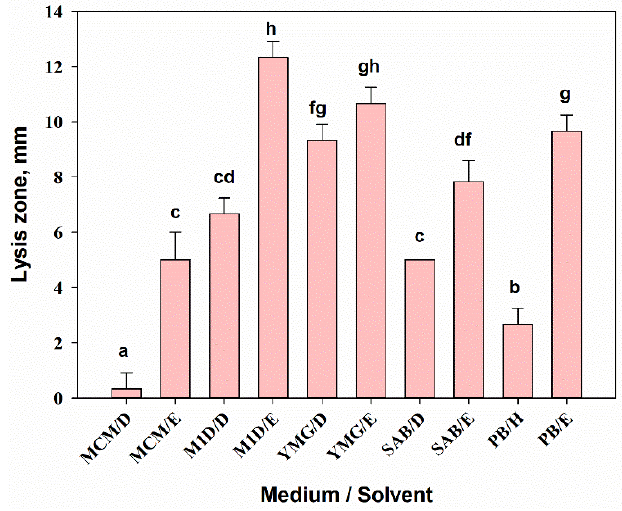
Figure 5. Antibacterial activity of extracts from Alternaria tenuissima MFP253011 cultures grown on various liquid and solid media 24 h post-treatment against Bacillus subtilis . Means ± std. deviation marked with the same letter did not differ significantly at the level of p = 0.05 according to Tukey’s HSD test. D—dichloromethane, E—ethyl acetate, H—hexane.